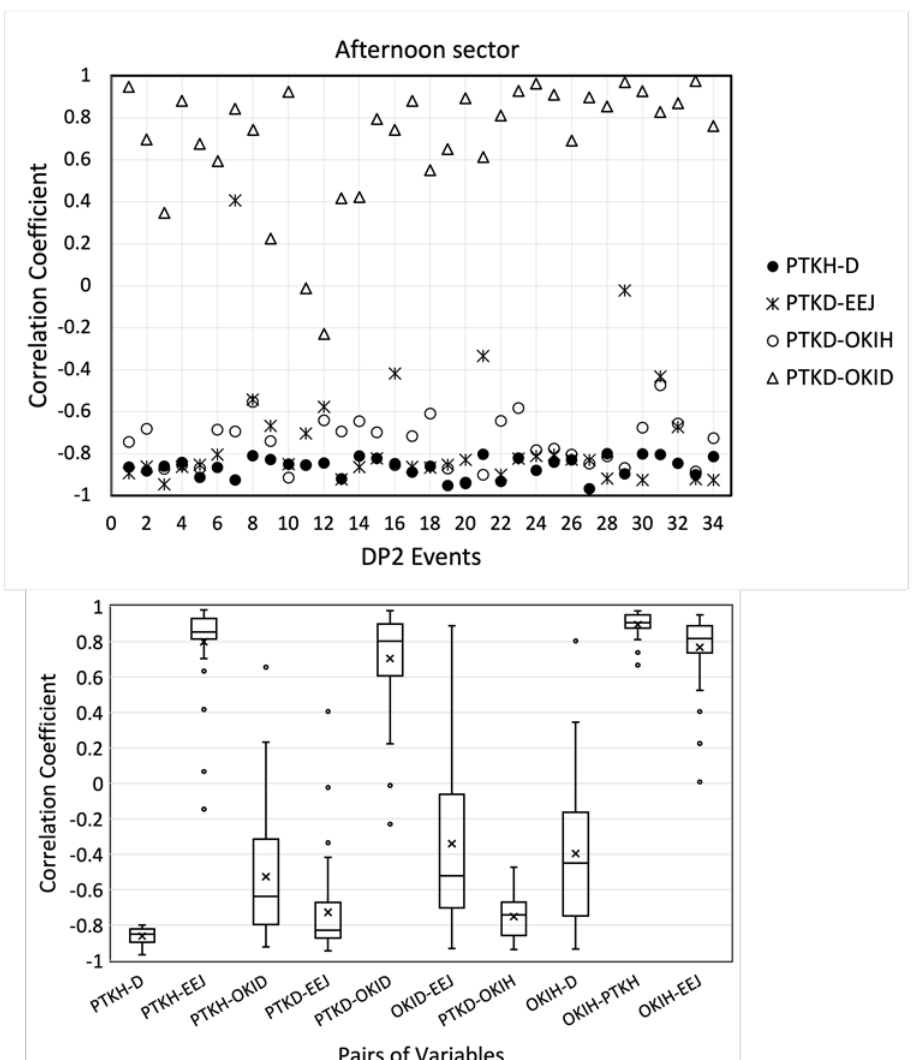
Figure 5. ( top ) Scatter plots of correlation coefficients and ( bottom ) box plots of all the correlation coefficients between two variables in the same format as in Figure